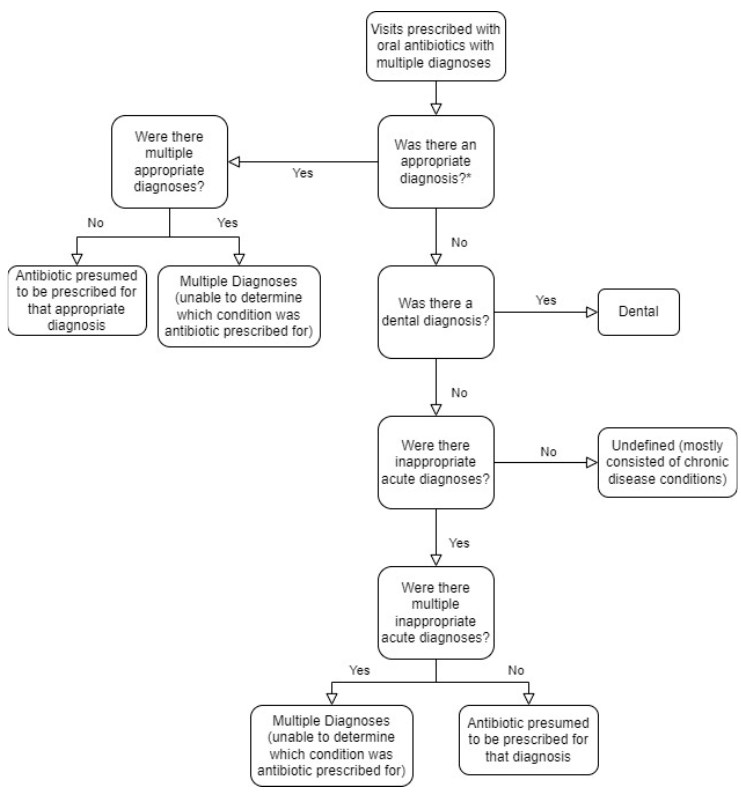
Figure A1. Tiered logic ranking system.